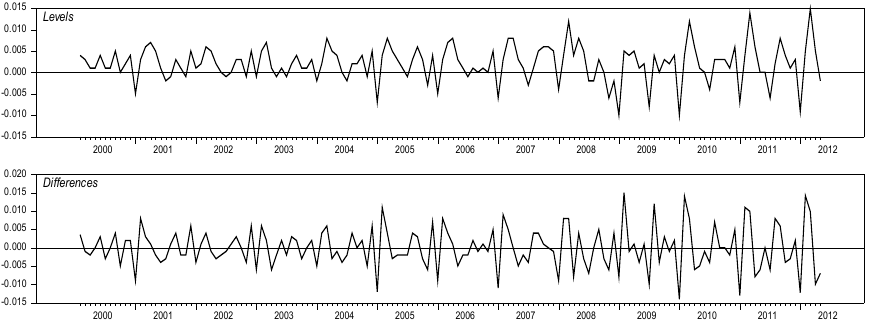
Figure 12. Consumer price index in the Eurozone I ( 1 ) . Data vector January 2000 to May 2012 (Great Depression).